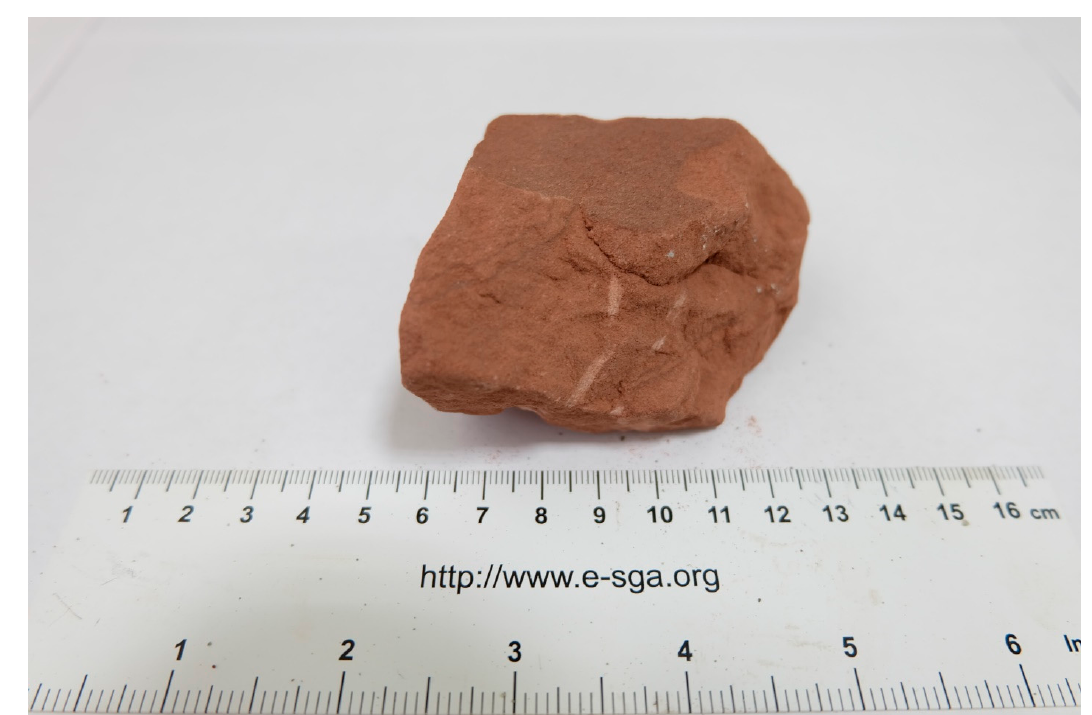
Figure A4. Red sandstone (sample ID 24CA_13), Vendian enclosing rocks of the near-pipe space ( V 2 ), Arkhangelskaya pipe.